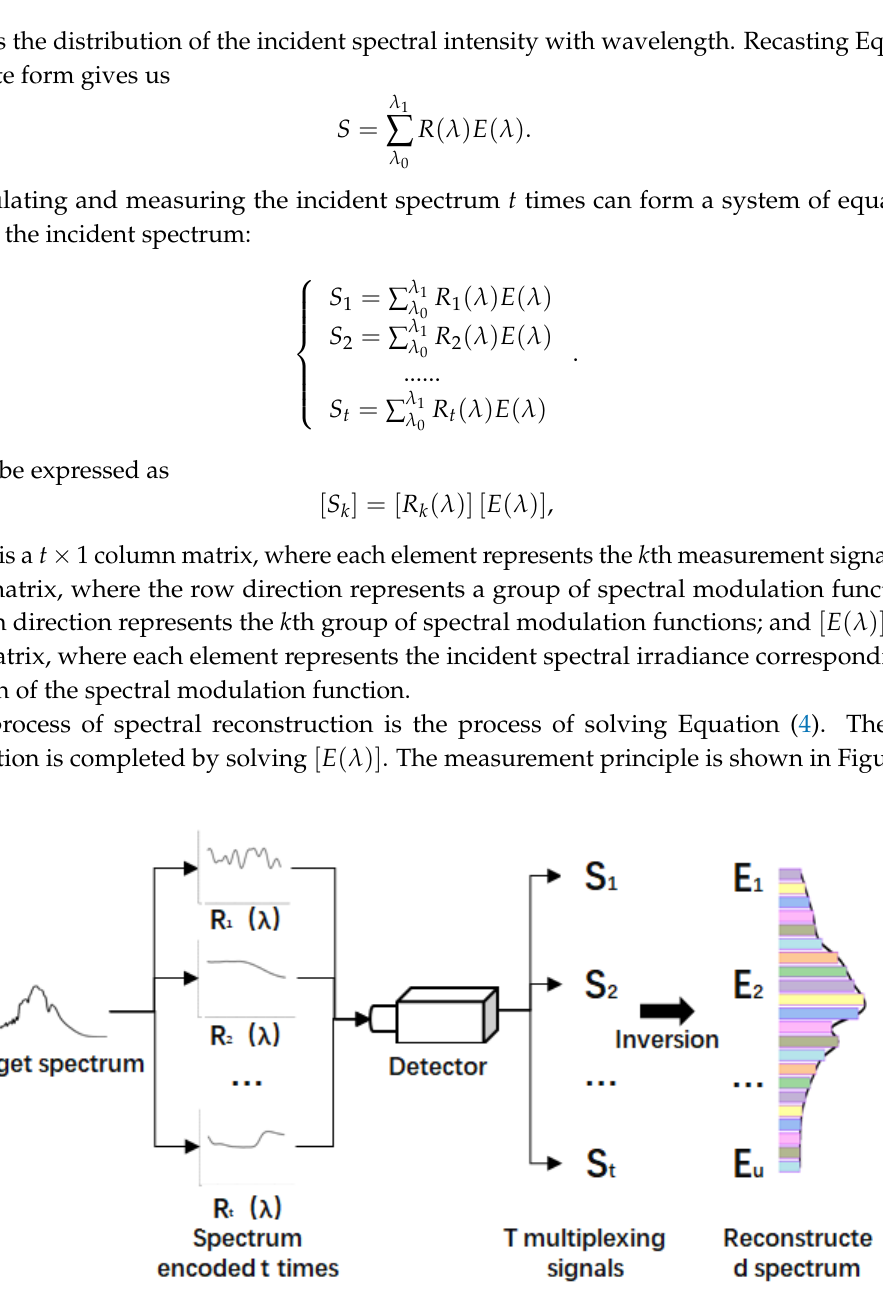
Figure 2. Spectral reconstruction